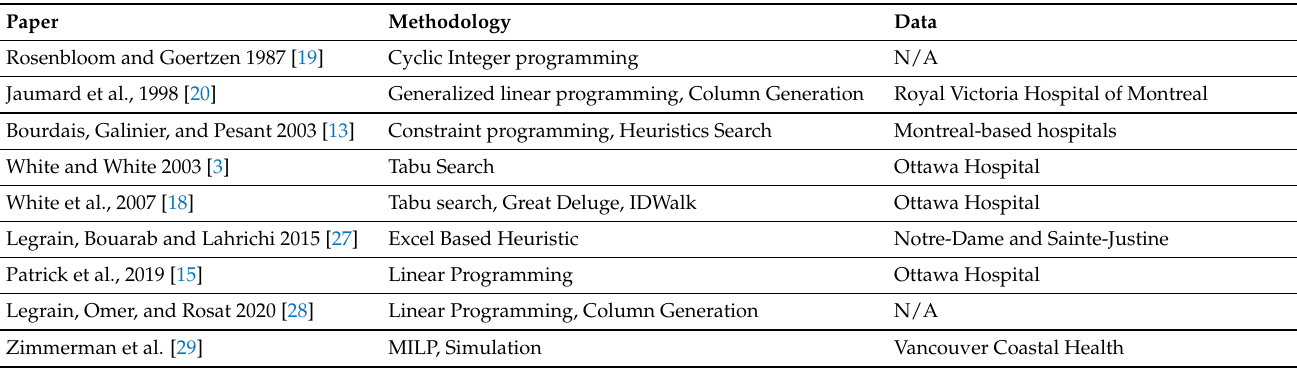
Table 1. General Staffing/Nurse Staffing